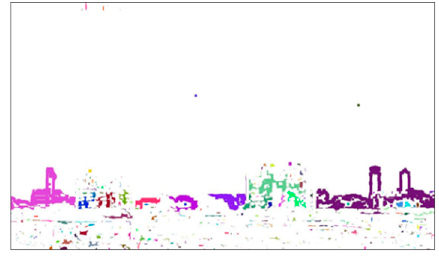
Figure 7. The difference image I d after image subtraction.